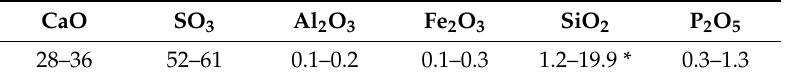
Table 3. Composition of phosphogypsum in terms of oxides, %.